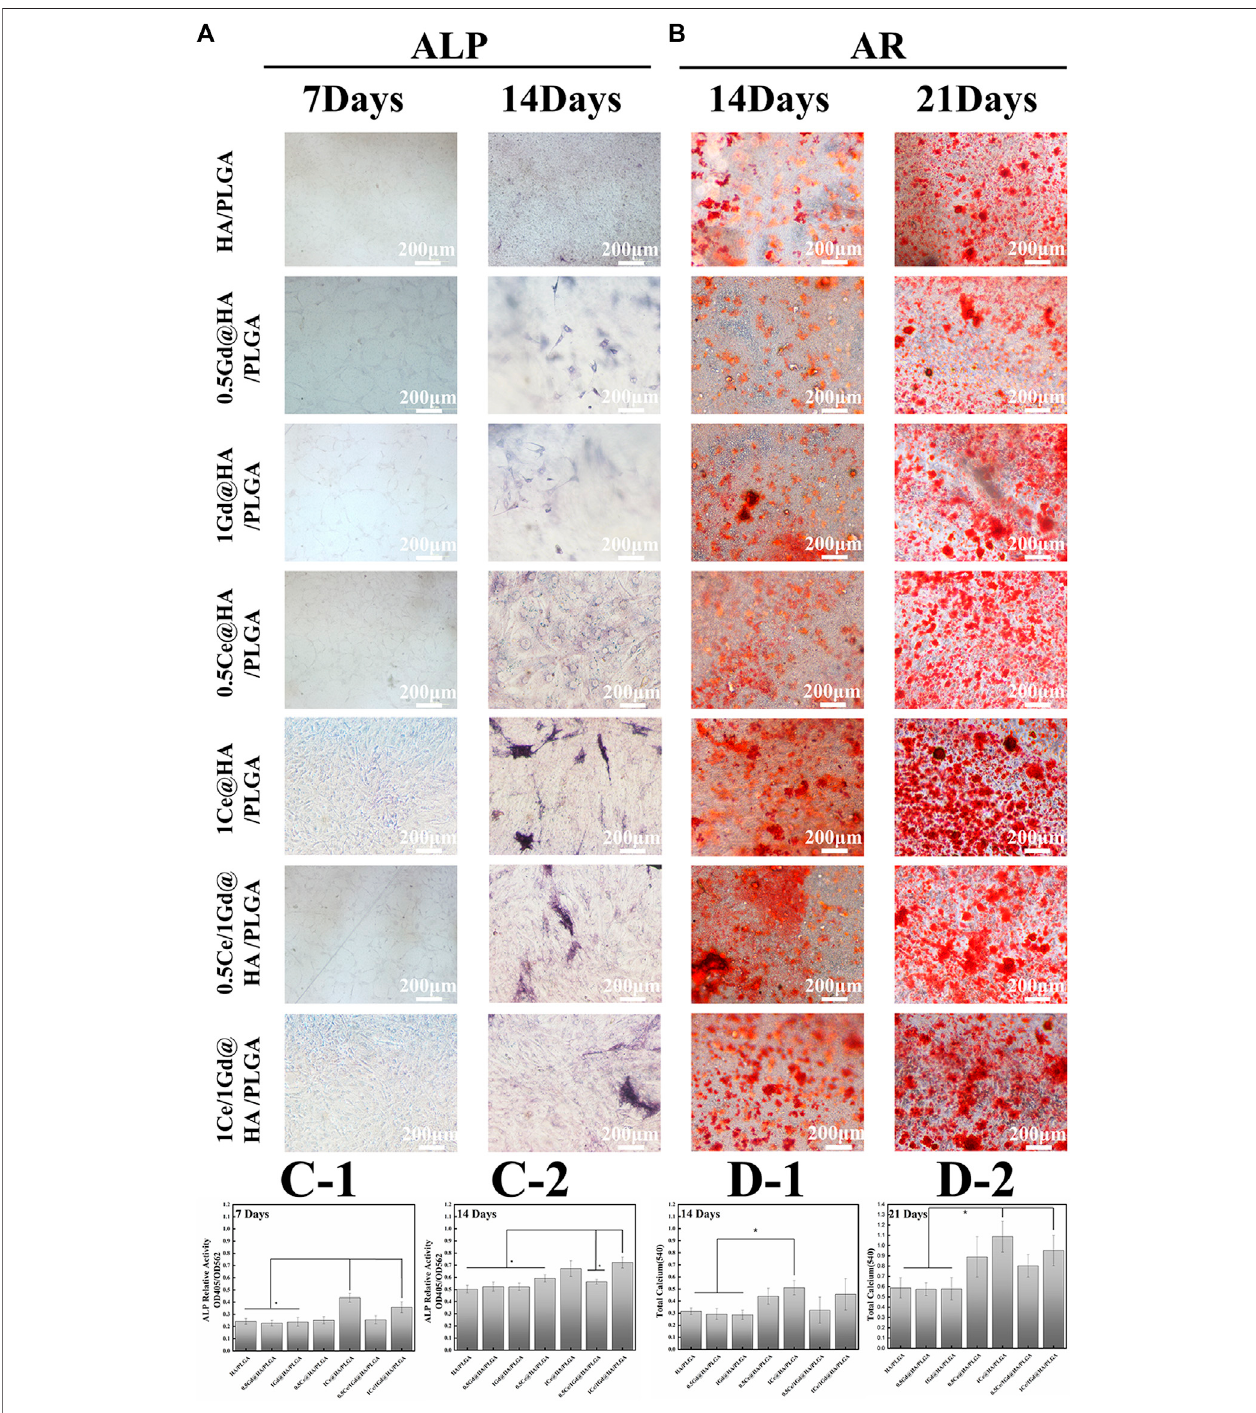
FIGURE 8 | MC3T3-E1 cells stained by (A) ALP and (B) AR cultured for 7 and 14 days and 14 and 21 days using different nanocomposites. Scale bar, 200 μ m. (C1-2) ALP activity of MC3T3-E1 cells cultured for 7 and 14 days was quantitatively evaluated using different nanocomposites. (D1-2) Different nanocomposites were used to quantitatively evaluate the calcium content and mineral deposition of MC3T3-E1 cells which was cultured for 14 and 21 days.* p < 0.05.